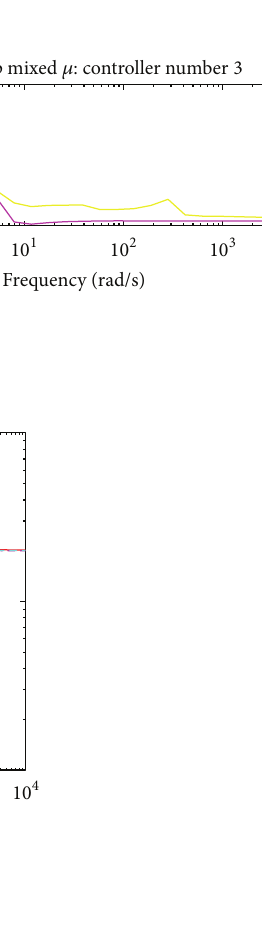
Figure 14: Comparison of robust stability for three